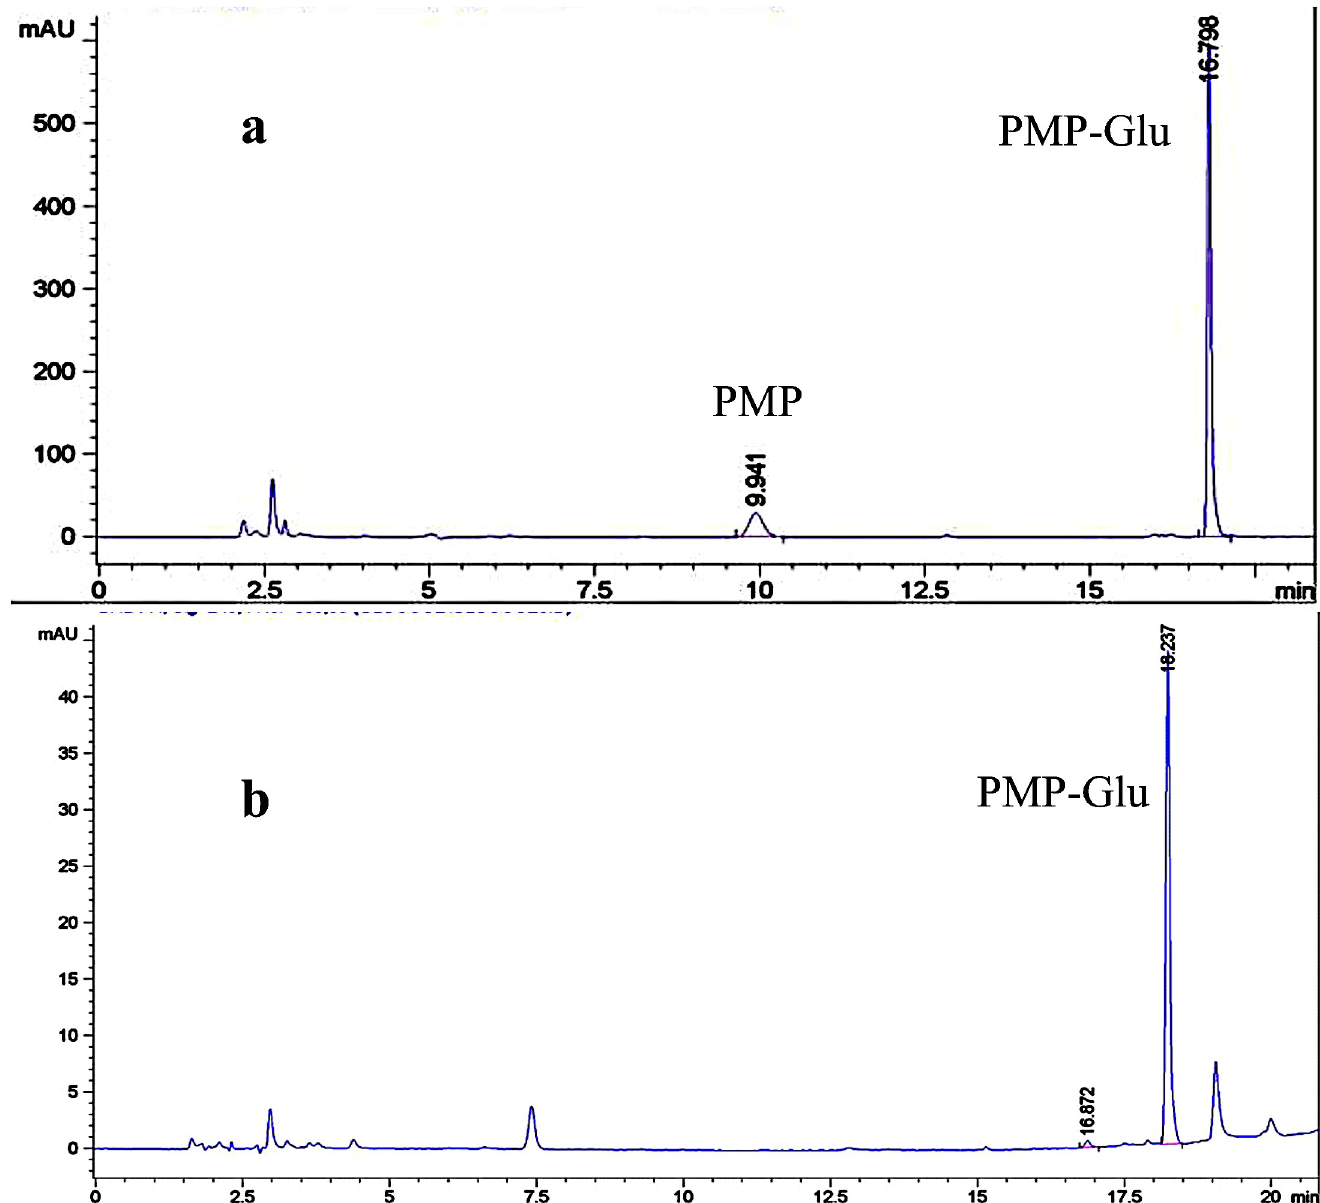
Fig 3. Representative chromatograms for a) blank TSB growth media and b) TSB supernatant extracted from a S . oneidensis culture.